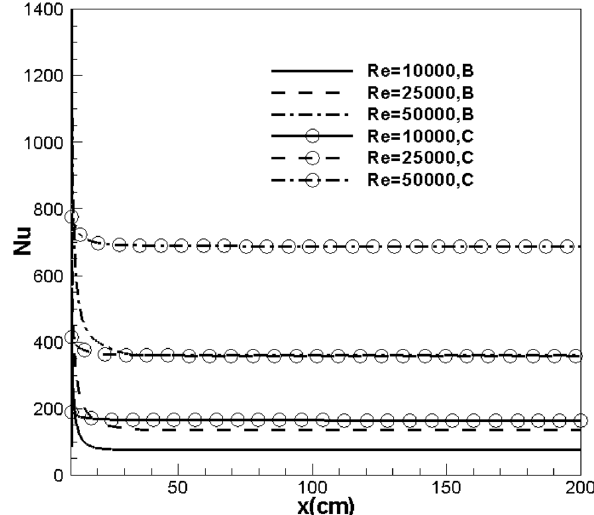
Fig. 9 Effect of solid–fluid thermal conductivity on Nu for bound- ary and central arrangements Fig. 10 Effect of Re on Nu for boundary and central